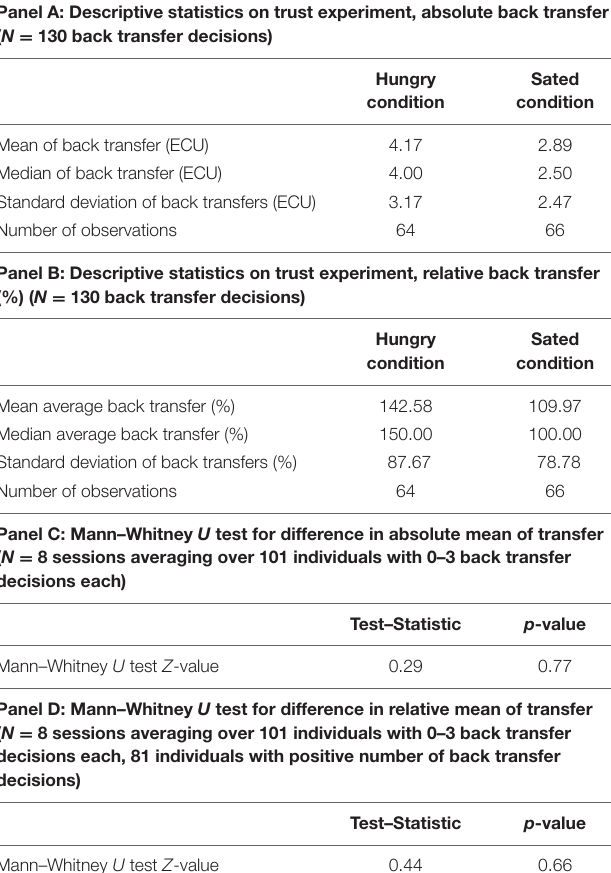
TABLE 2 | Back transfers in the trust